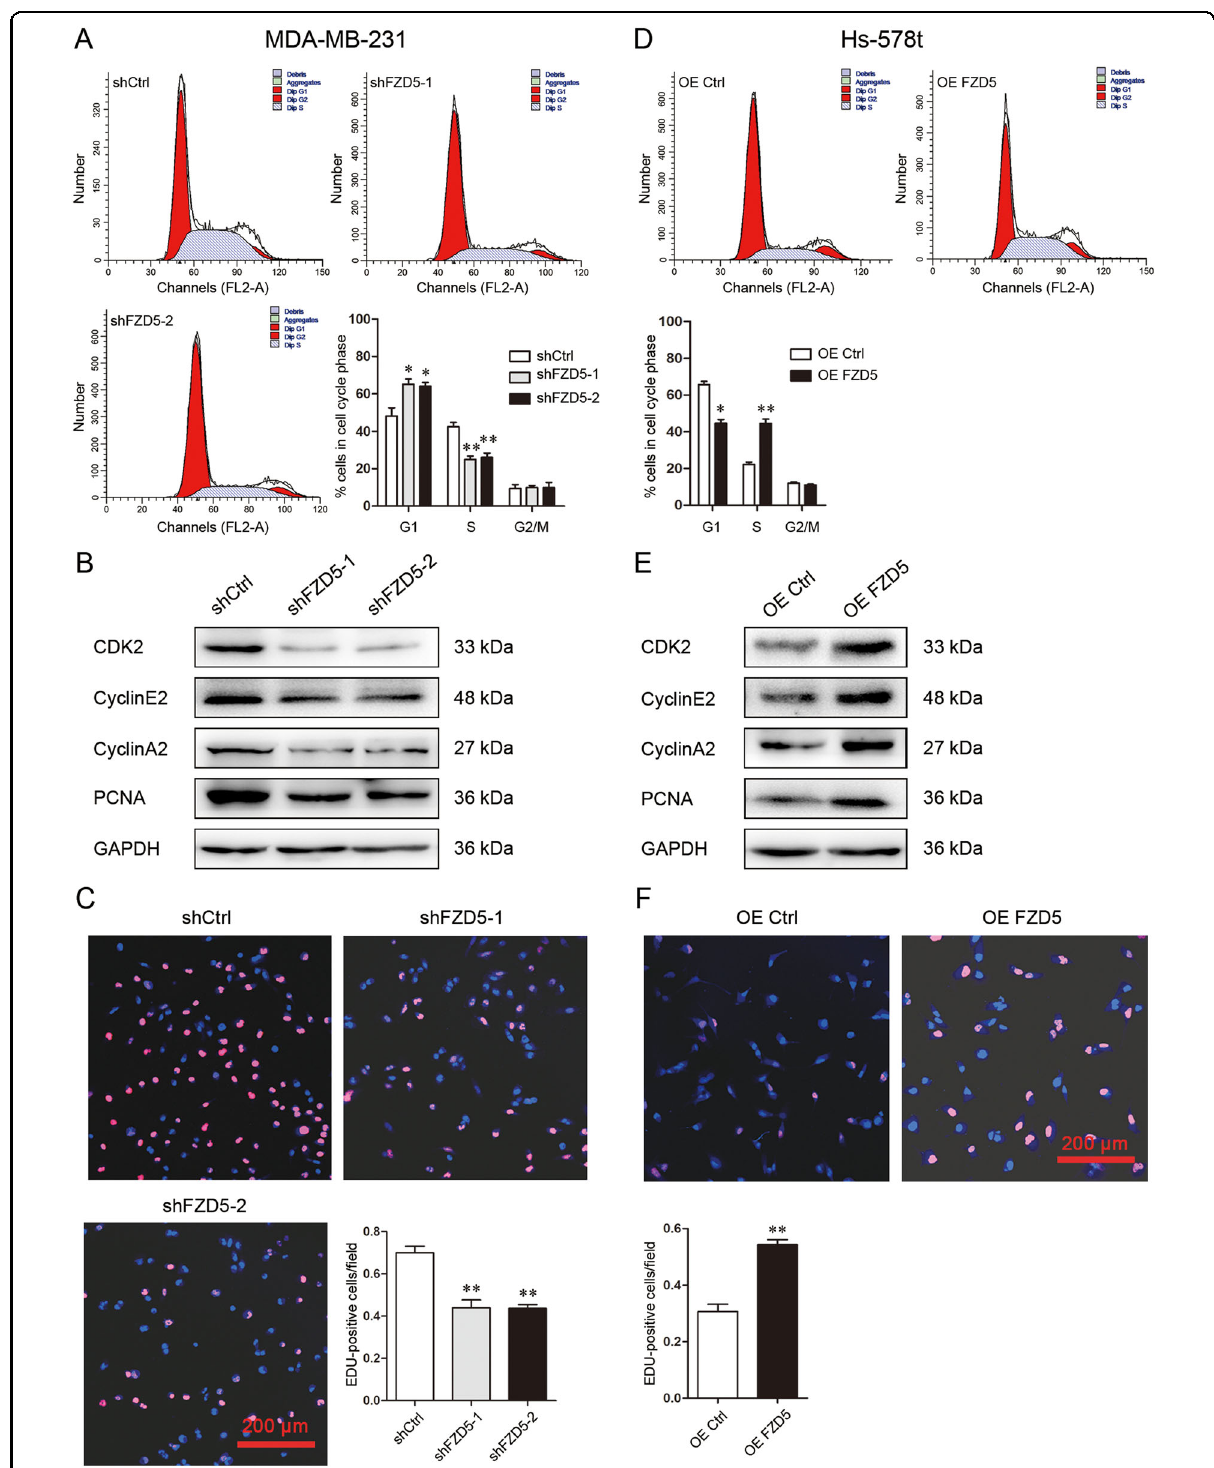
Fig. 3 FZD5 promotes G1/S transition and DNA replication. A Cell cycle of MDA-MB-231 cells was analyzed by fl ow cytometry. B CDK2, Cyclin E2, Cyclin A2, and PCNA expression in MDA-MB-231 cells was detected by Western blot. C DNA replication of MDA-MB-231 cells was analyzed by EDU staining. Scalebar: 200 μ m, mean ± SD, n = 3. * P < 0.05, ** P < 0.01, vs. shCtrl. D Cell cycle of Hs-578t cells was analyzed by fl ow cytometry. E CDK2, Cyclin E2, Cyclin A2, and PCNA expression in Hs-578t cells was detected by Western blot. F DNA replication of Hs-578t cells was analyzed by EDU staining. Scale bar: 200 μ m, mean ± SD, n = 3. * P < 0.05, ** P < 0.01, vs. OE